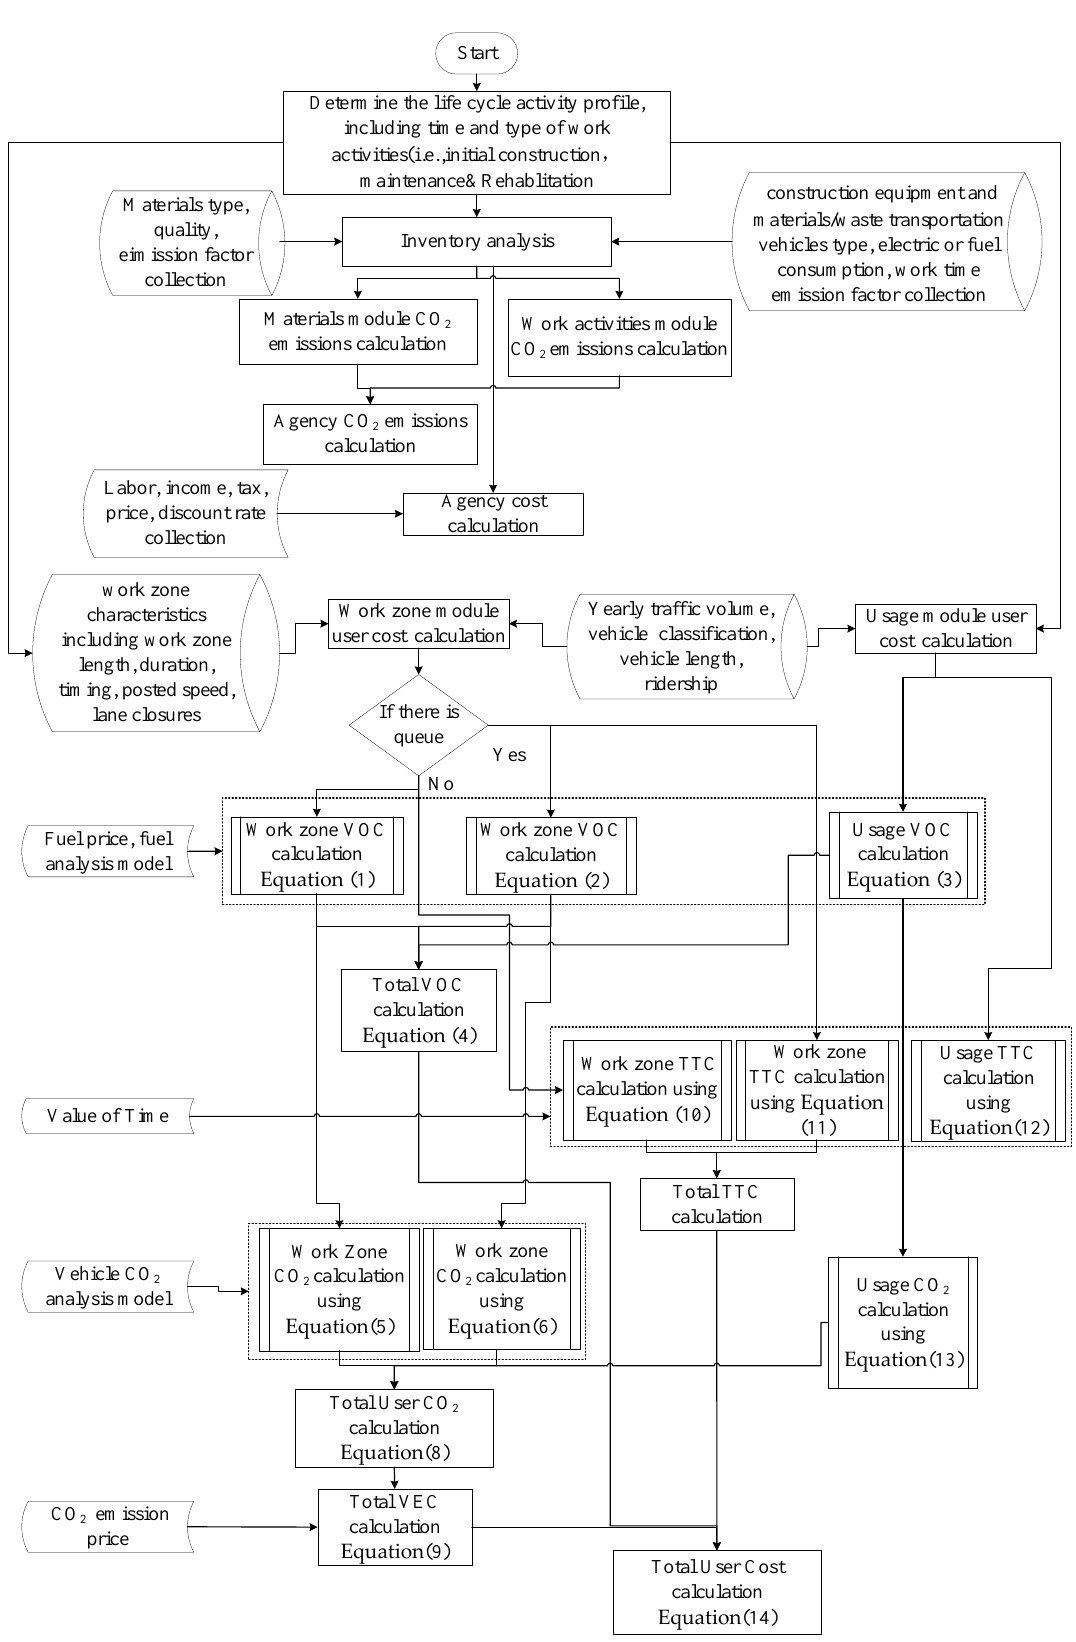
Figure 2. Detail methodology of the framework proposed in this research.